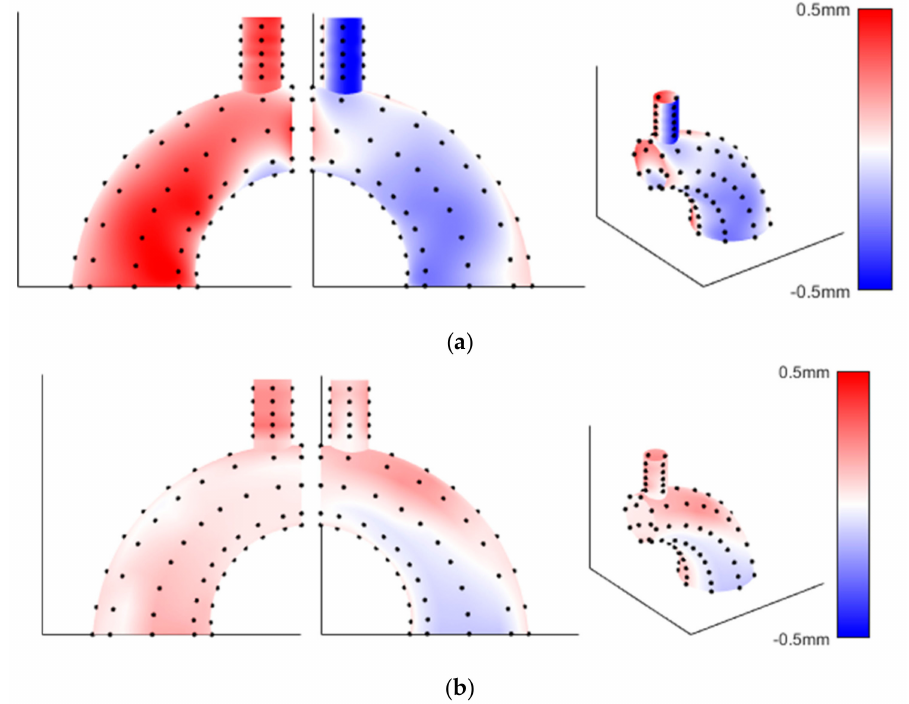
Figure7. Distributionofwallthicknessvariationfortheinitial( a )andsecond( b )phantom. Theintended wall thickness was 1